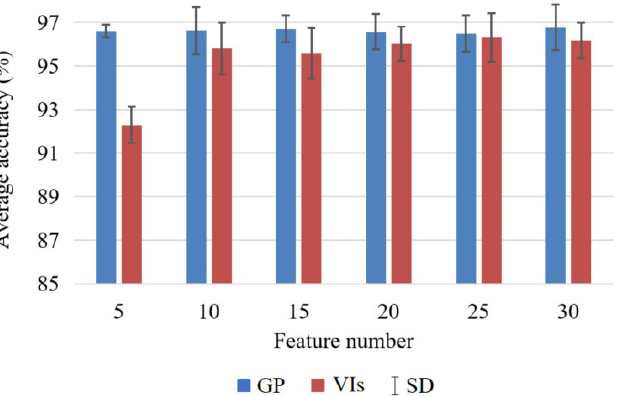
Figure 13. The average accuracies and SDs of GP and VIs using different classifiers and feature numbers.